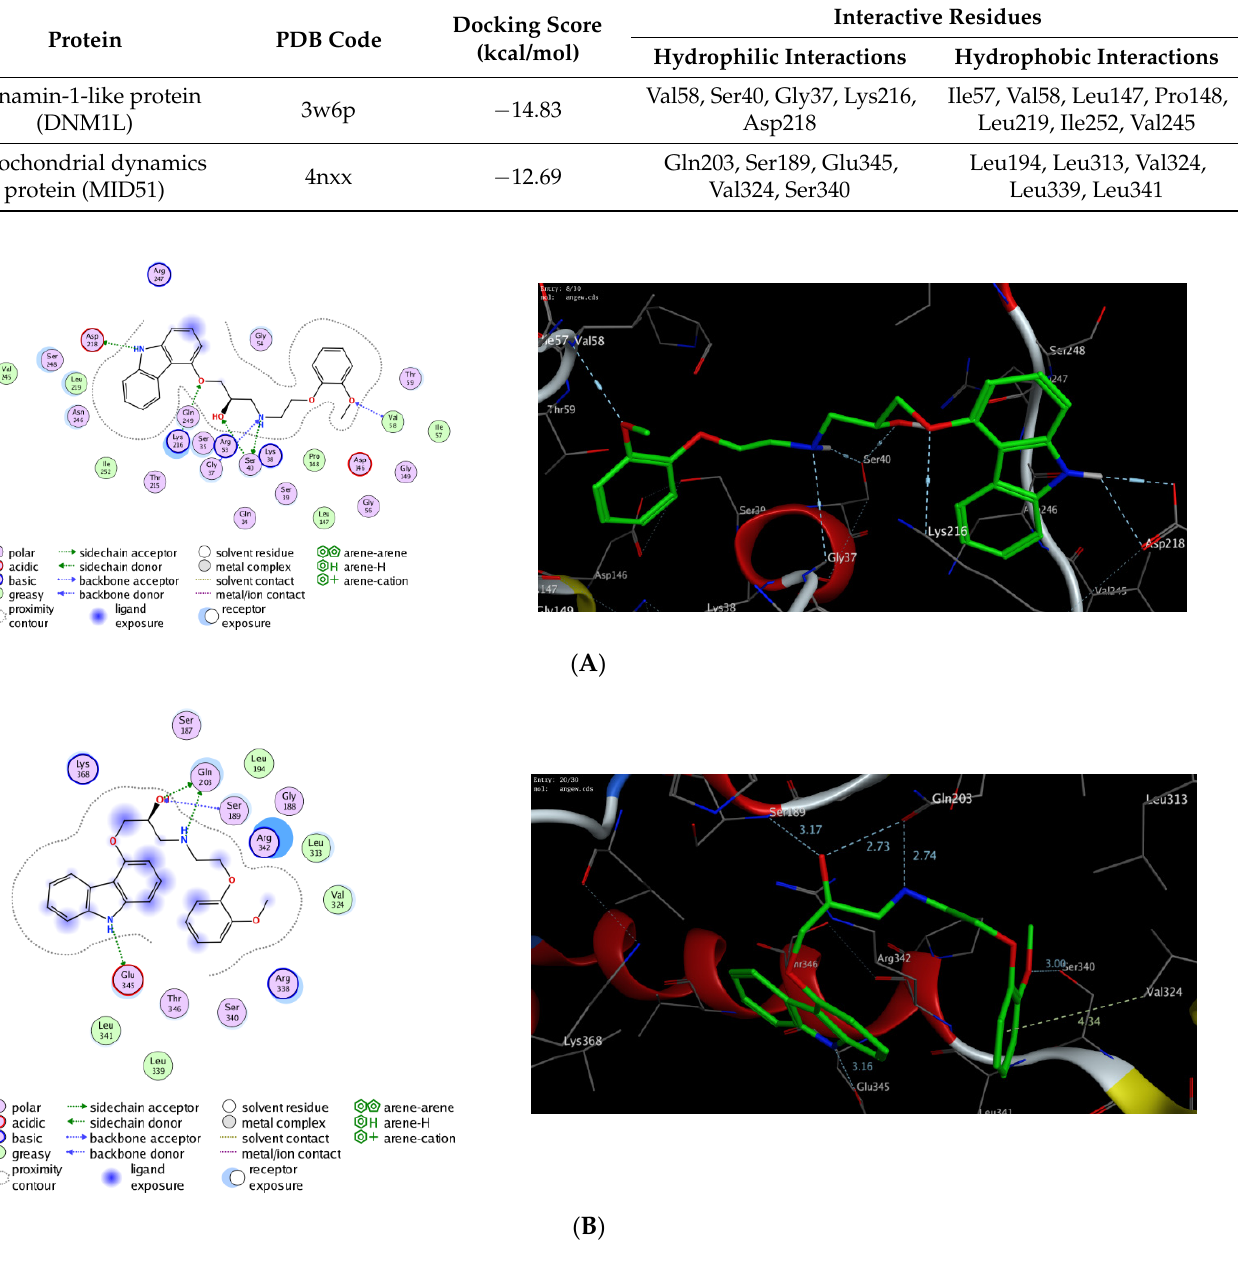
Figure 14. The (2D and 3D) molecular modelling interactions of carvedilol (green in 3D interactions) with dynamin-1-like protein (PDB code: 3w6p ) ( A ), and mitochondrial dynamics protein (PDB code: 4nxx ) ( B ). The hydrophobic interactions are shown as dotted blue arrows; (C atoms are colored grey, N blue and O red).